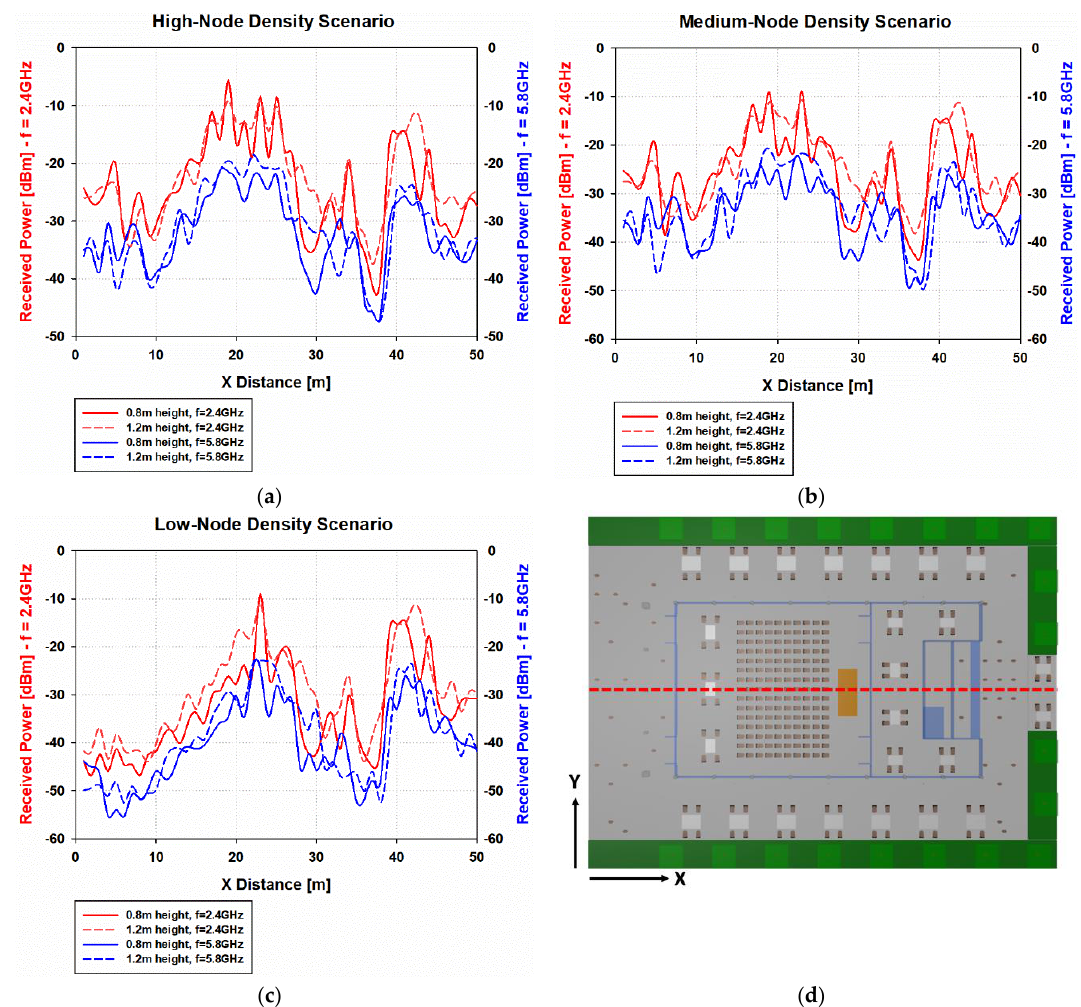
Figure 5. Linear distribution of received power [dBm] for different heights and frequency bands for Y = 20 m along the X-axis, ( a ) high-node density scenario, ( b ) medium-node density scenario, ( c ) low-node density scenario, and ( d ) radial line representation.